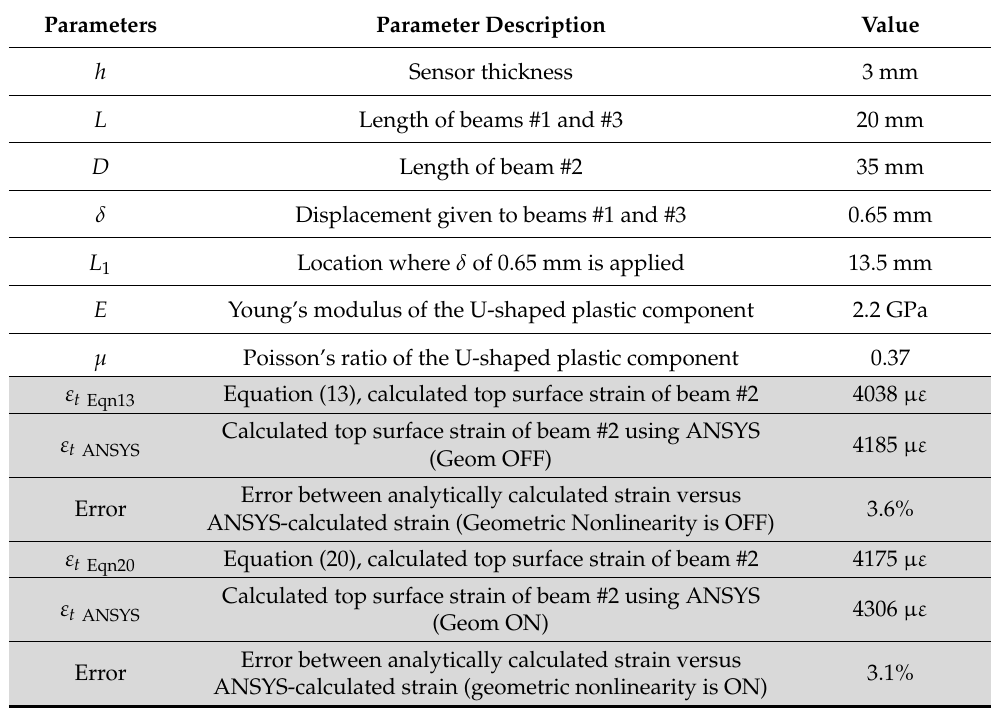
Table 1. Baseline parameters used in ANSYS to verify Equations (13) and (20).